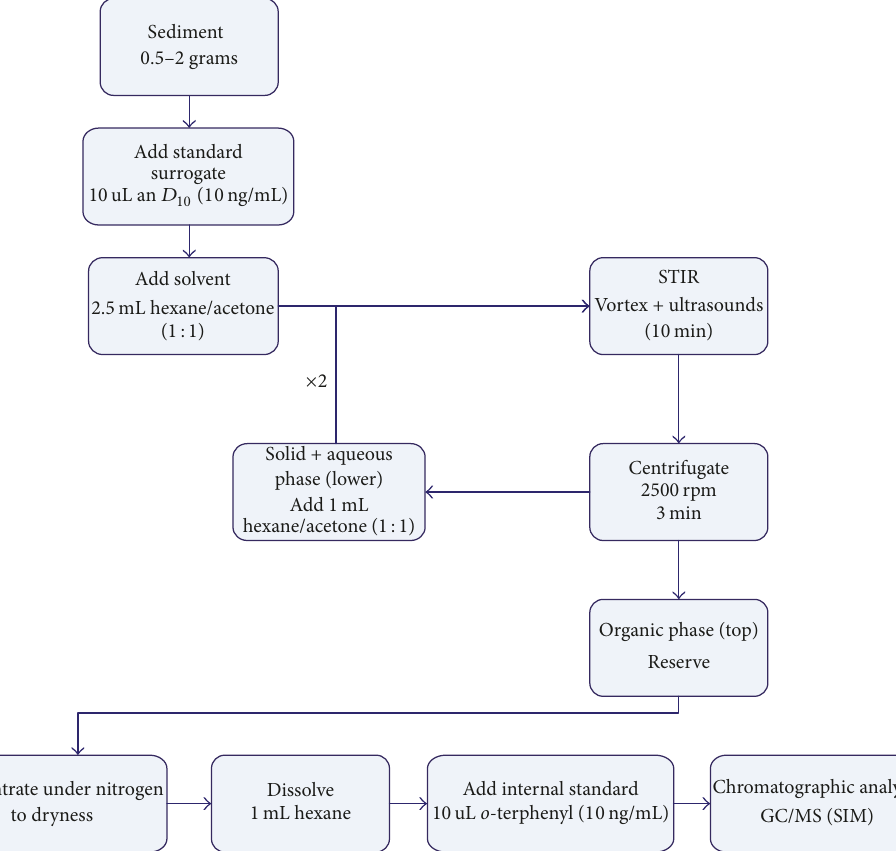
Figure 2: Scheme of the proposed analytical method to quantify the selected organochlorine pesticides and PCBs in sediments.